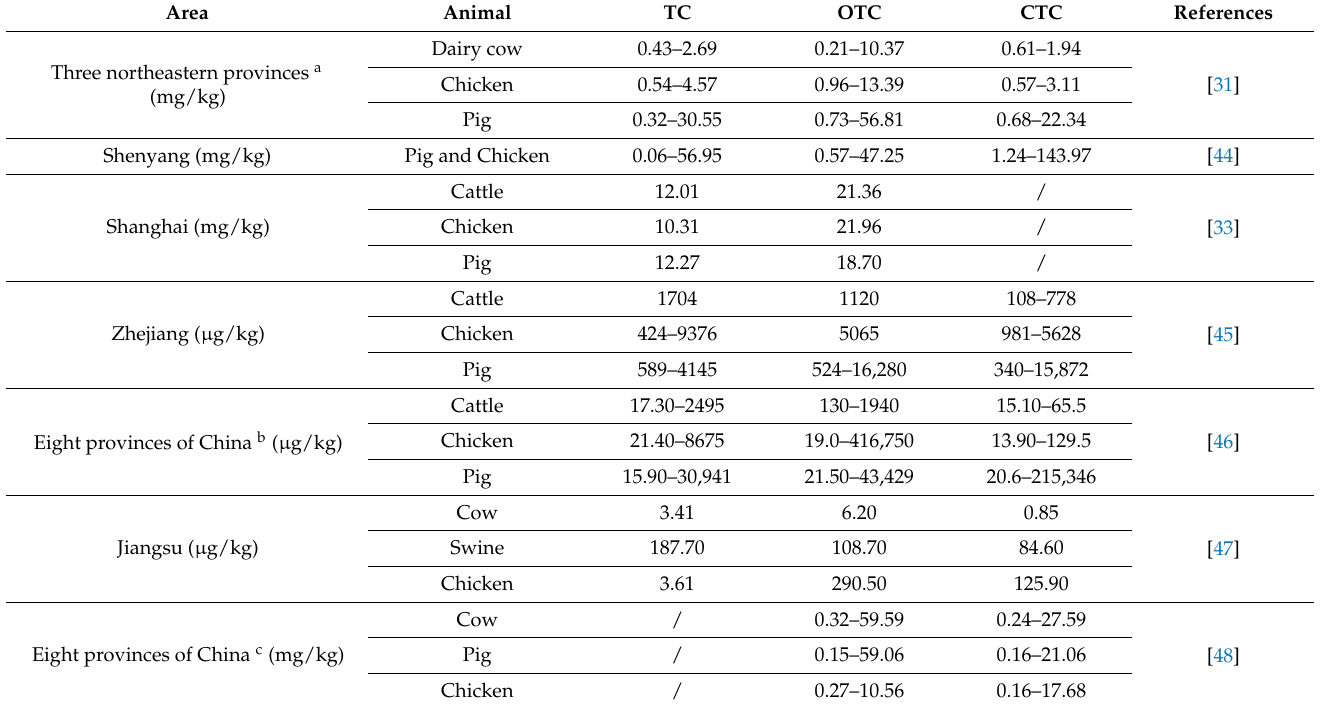
Table 1. TCs’ residual content in animal